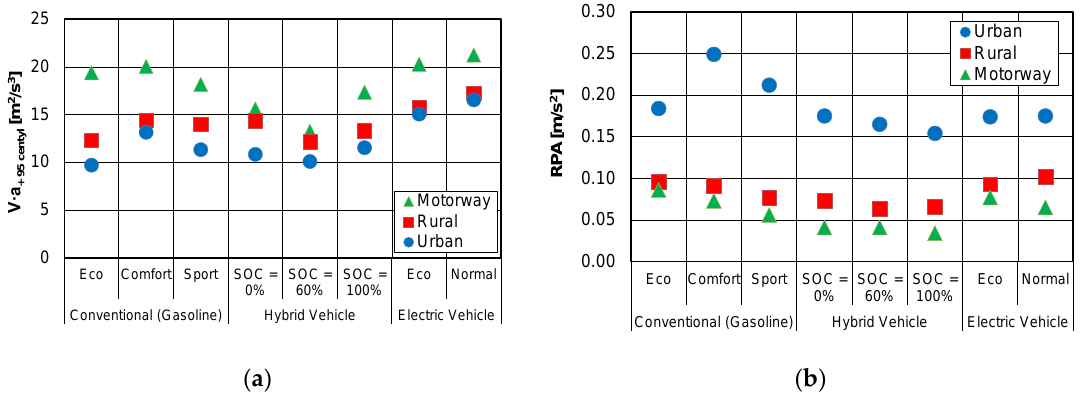
Figure 7. Comparison of the dynamic parameters of the RDE test in its individual portions for all the investigated vehicles: ( a ) centile of the 95% product of velocity and positive acceleration, ( b ) relative positive acceleration.